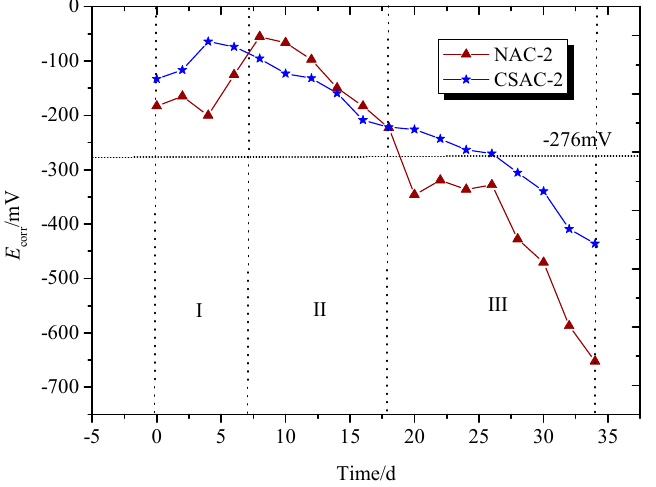
Figure 5. Time-varying curves of corrosion potential of reinforcement in NAC and CSAC.